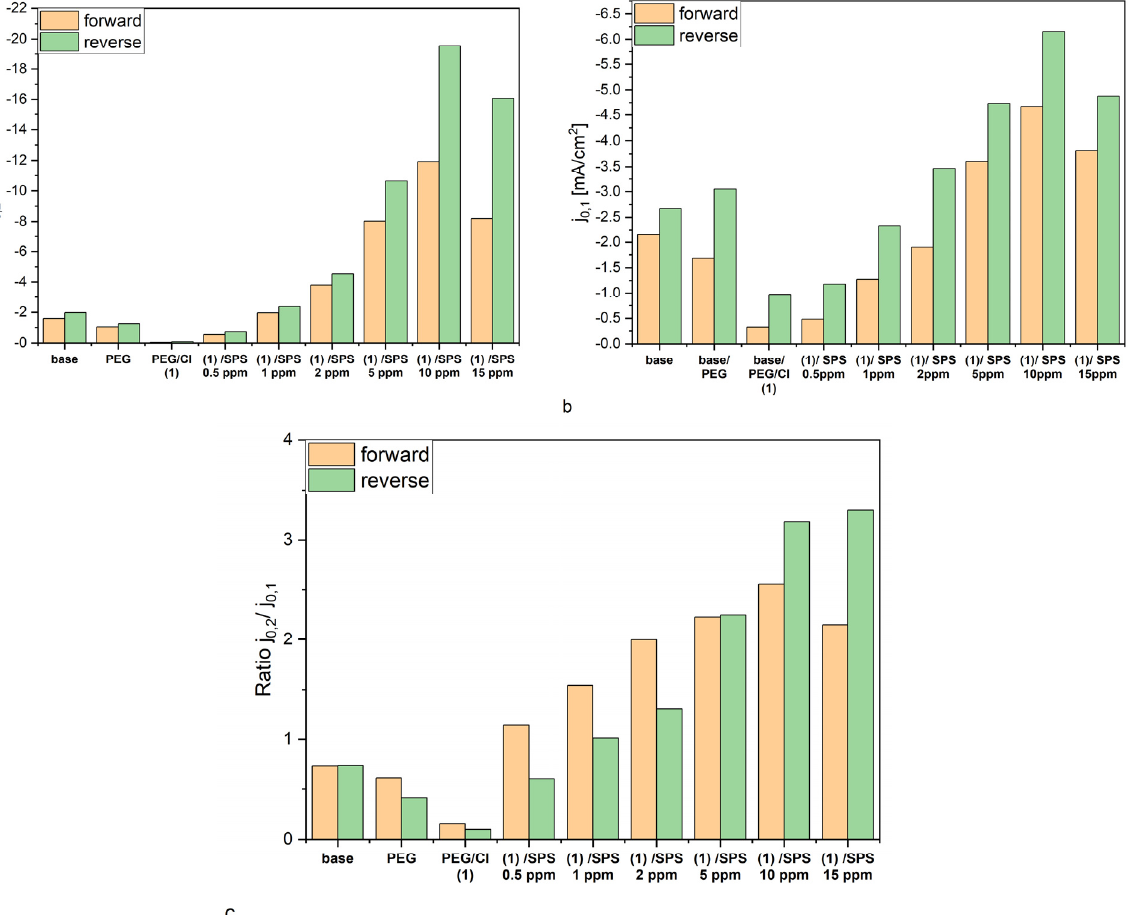
Figure 2. Exchange current densities j 0,1 ( b ) and j 0,2 ( a ) and the ratio j 0,2 / j 0,1 ( c ) for the base, base/PEG, base/PEG/Cl, and base/PEG/Cl/SPS at concentrations 0.5, 1, 2, 5, 10, and 15 ppm. The orange bars correspond to the forward scan and the green bars to the reverse scan.